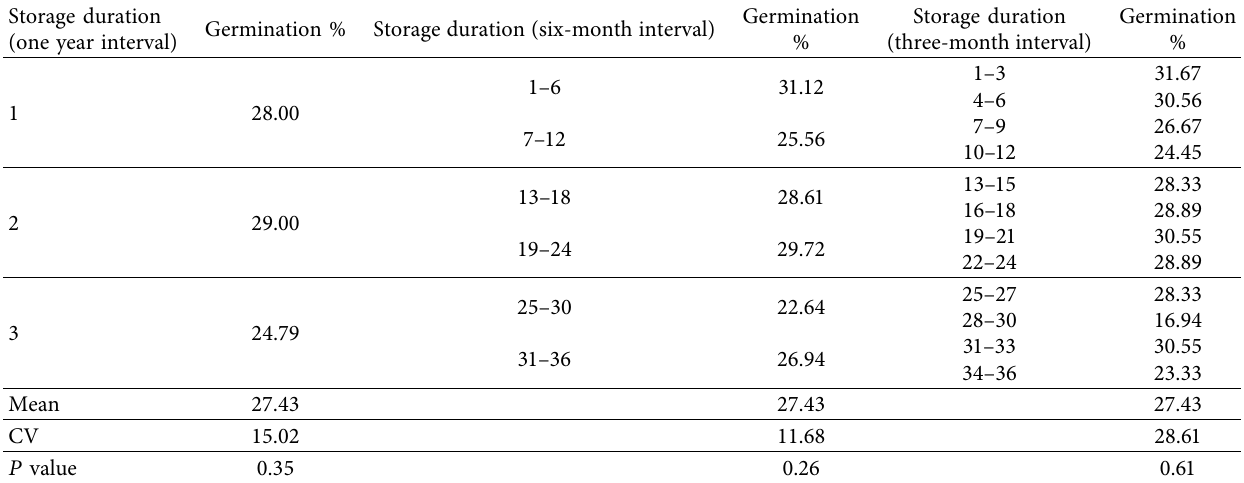
Table 3: Germination performance of tagasaste ( Chamaecytisus palmensis ) seed stored at different storage duration intervals. Storage duration